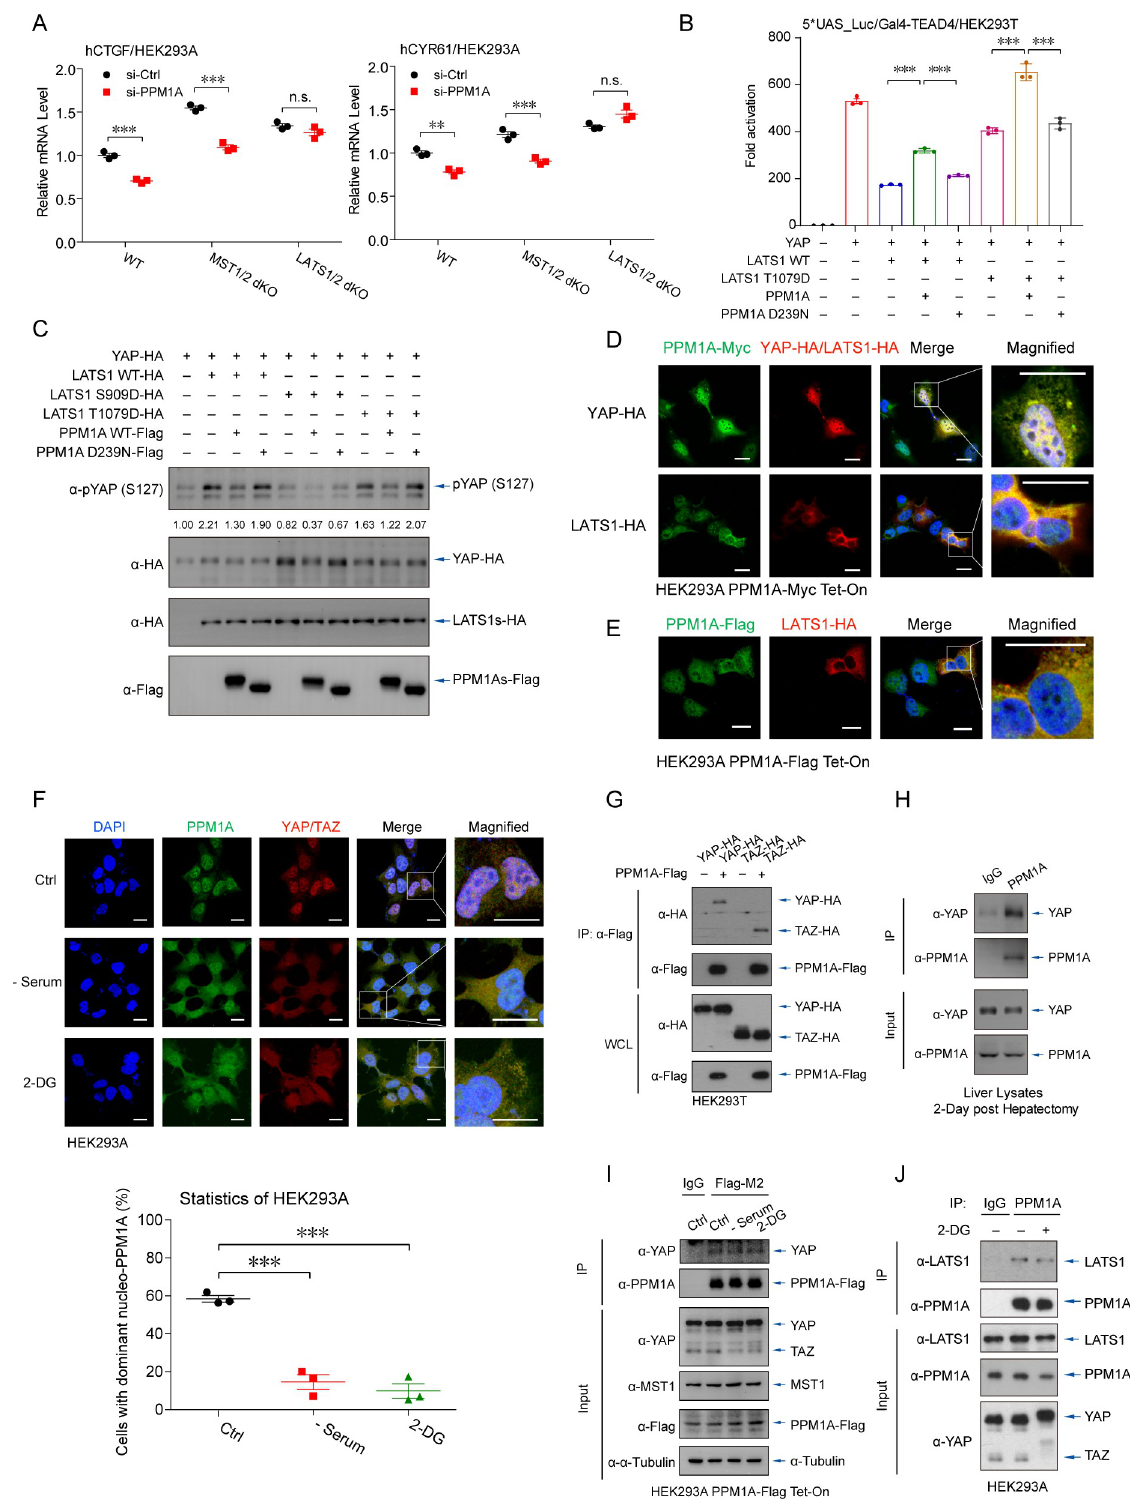
Fig 3. PPM1A translocates and associates with YAP/TAZ and LATS kinases. (A) Upon PPM1A depletion, qRT-PCR assays detected the significantly lower mRNA levels of YAP/TAZ target genes in WT or MST1/2 dKO cells, but not in LATS1/2 dKO cells. (B, C) The transcription potency of YAP that was inhibited by LATS1 T1079D, a LATS1 phosphomimetic, was restored by PPM1A cotransfection (B).